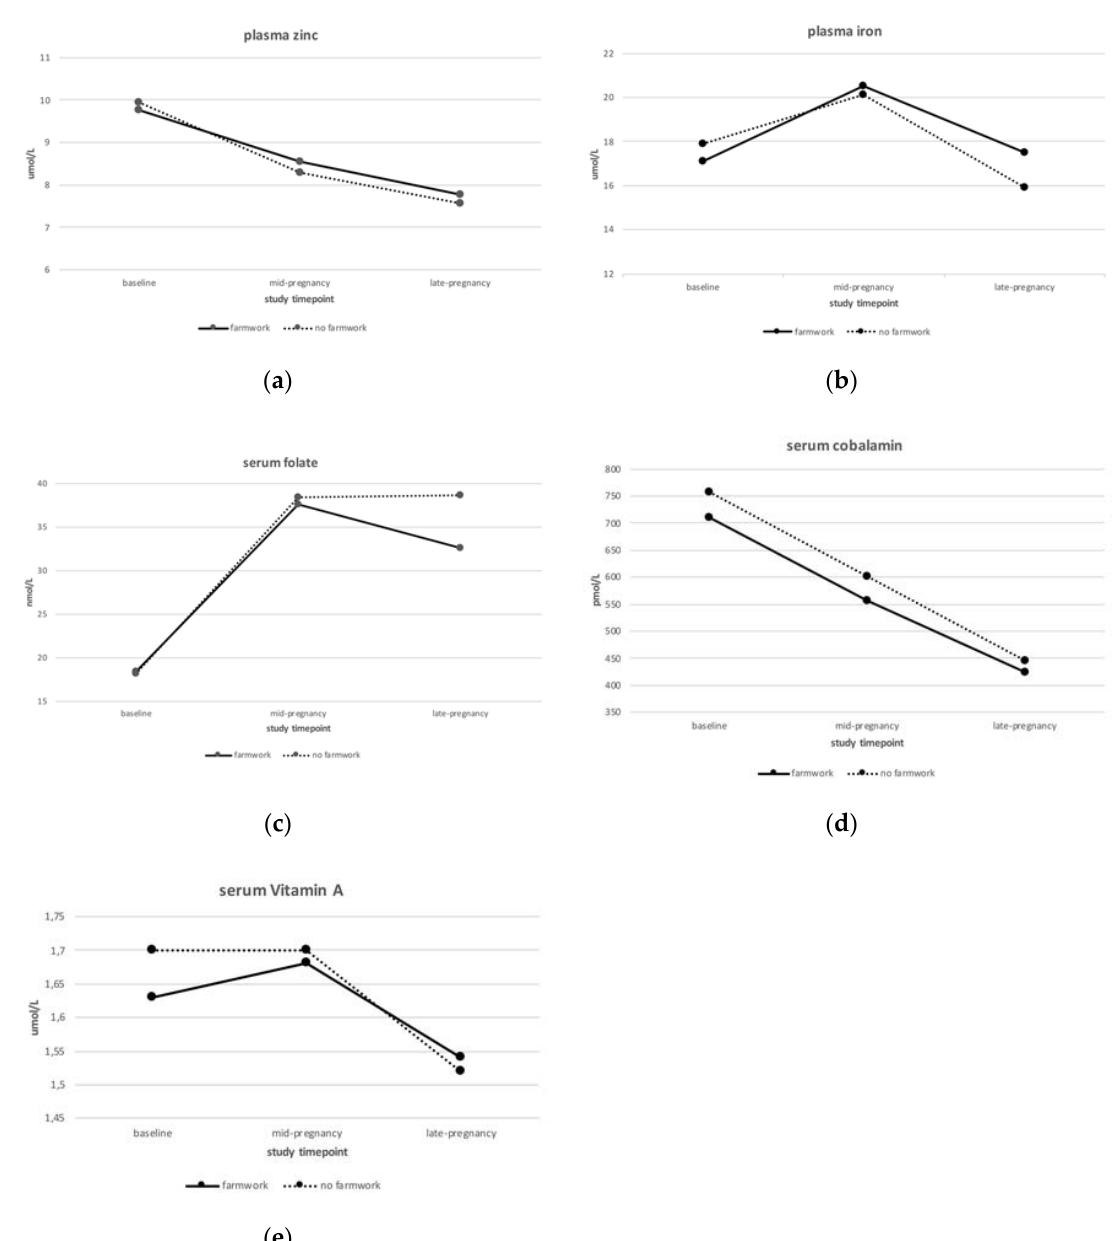
Figure 2. Biomarker trajectories from baseline visit (before conception) to late pregnancy by farm-work status for ( a ) plasma zinc; ( b ) plasma iron; ( c ) serum folate; ( d ) serum cobalamin; and ( e ) serum vitamin A.